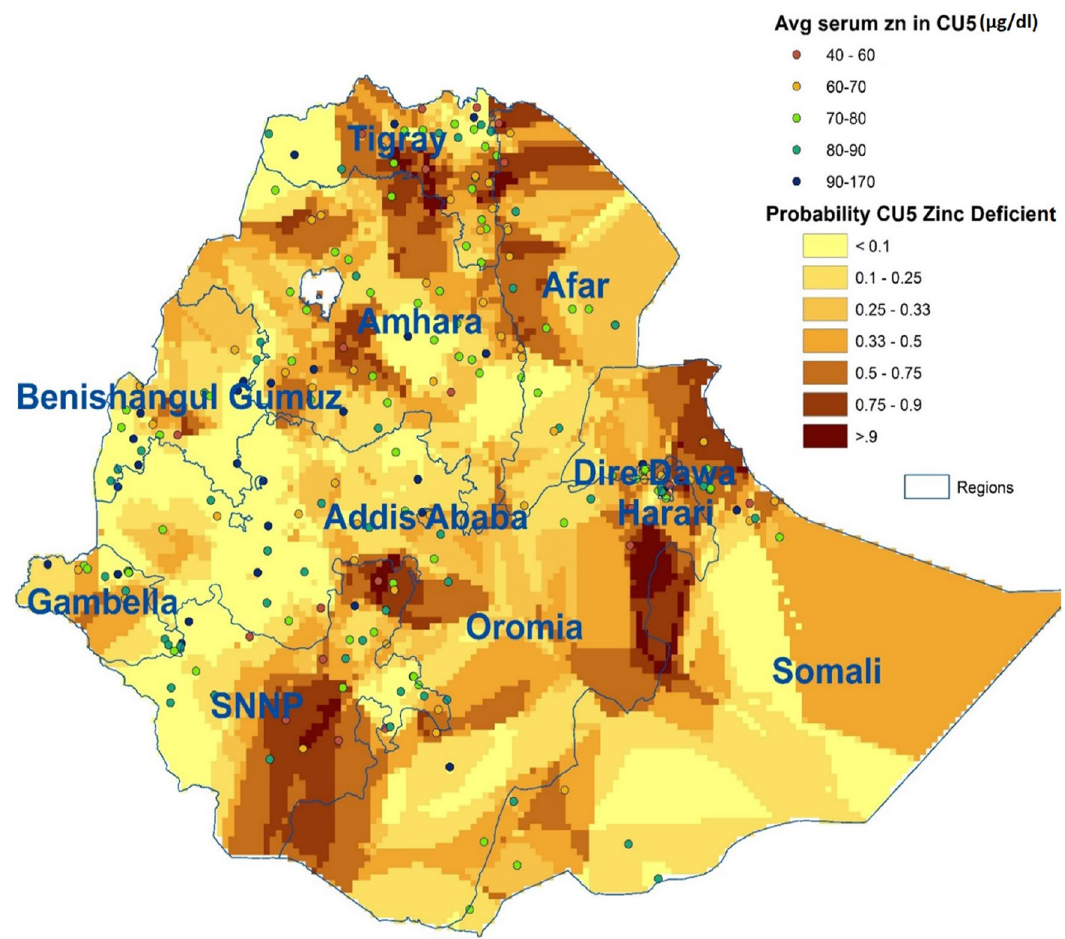
esri. com/ en- us/ arcgis/ produ cts/ arcgis- deskt op/ overv